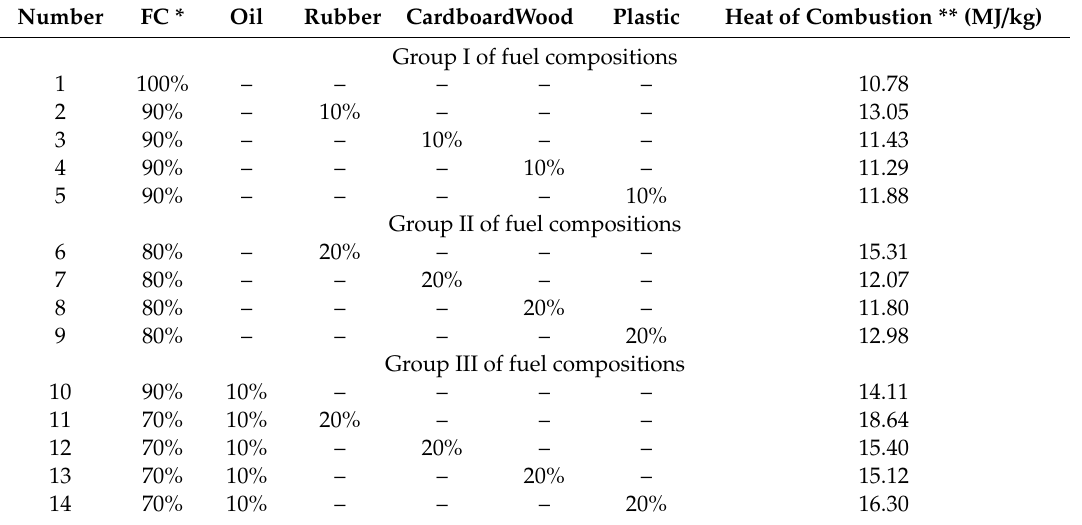
Table 2. Fuel compositions.